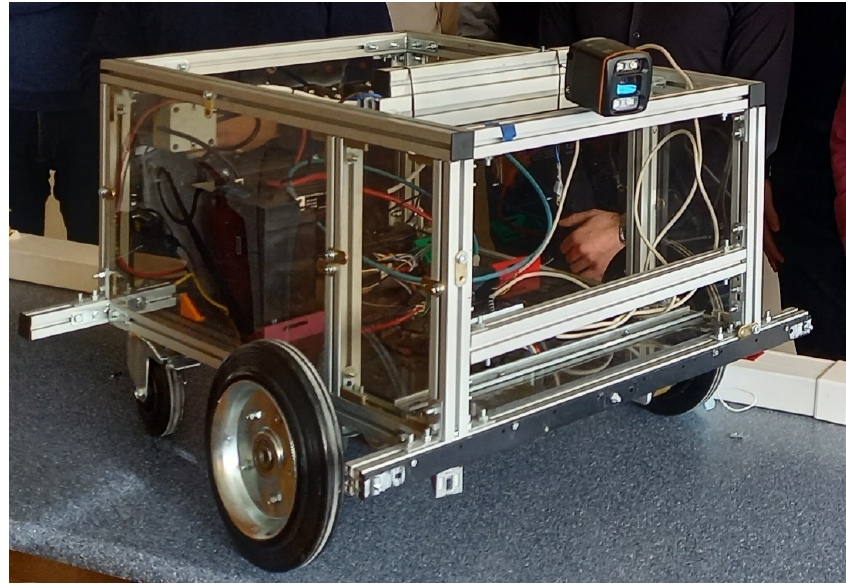
Figure 1. Experimental AGV